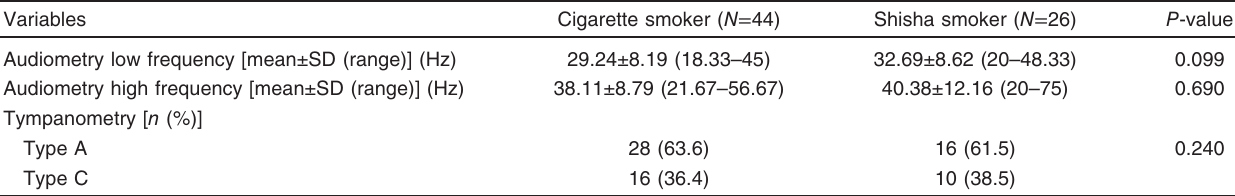
Table 5 Comparison of types of smoking in chronic obstructive pulmonary disease Variables